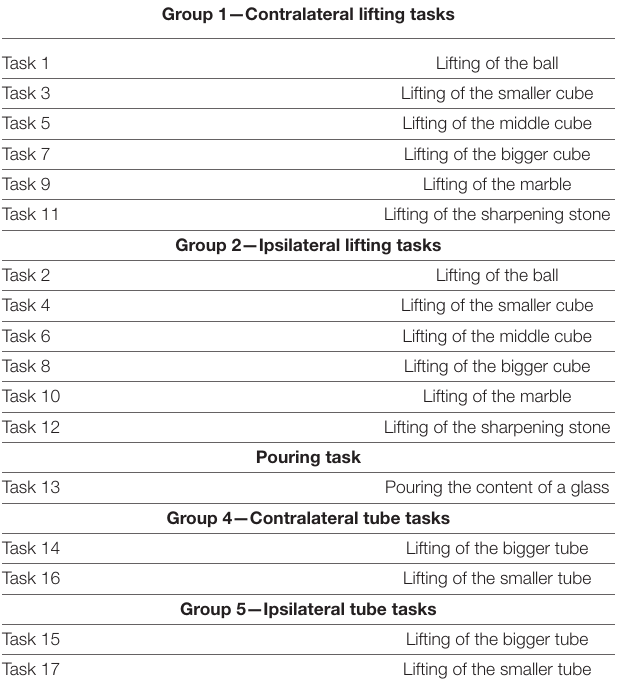
TABLE 2 | Functional division of the tasks. Group 1—Contralateral lifting